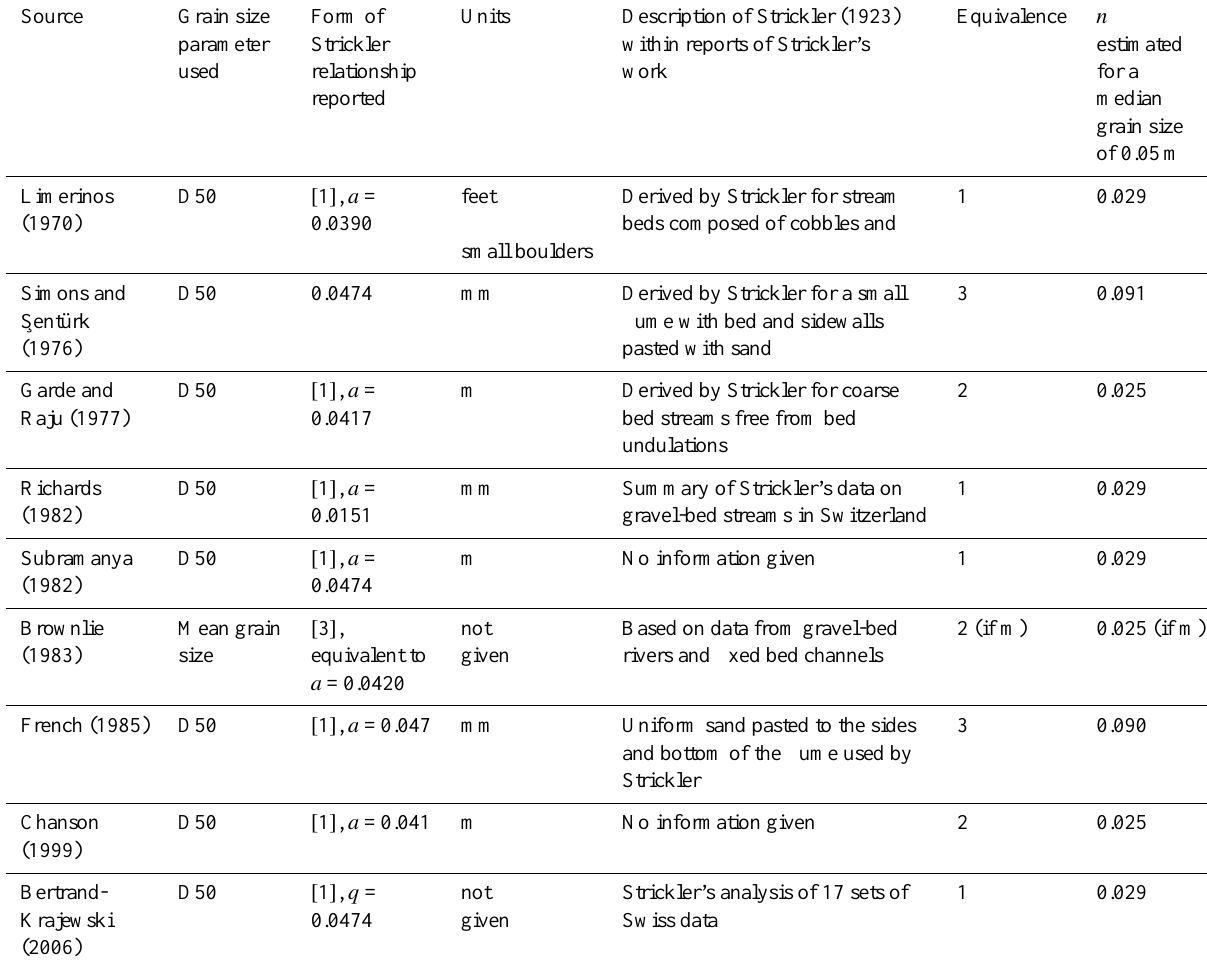
Table 2. Different forms of the Manning–Strickler